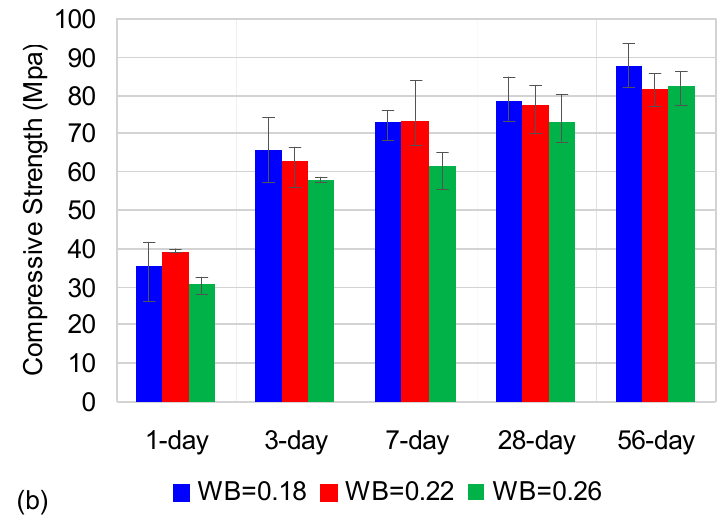
Figure 7. Effect of WB and curing temperature on compressive strength:( a ) 23 ± 2 °C and ( b ) 40 ± 2 °C.